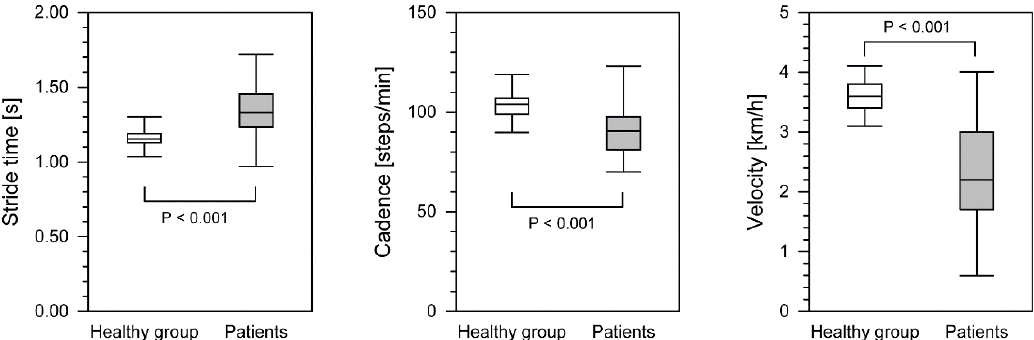
Figure 4. The differences in gait parameters between healthy group and patients after treatment with the Ilizarov method. The boundary of the box closest to zero indicates the 25th percentile, a line within the box marks the median, and the boundary of the box farthest from zero indicates the 75th percentile. Whiskers above and below the box indicate the 90th and 10th percentiles.